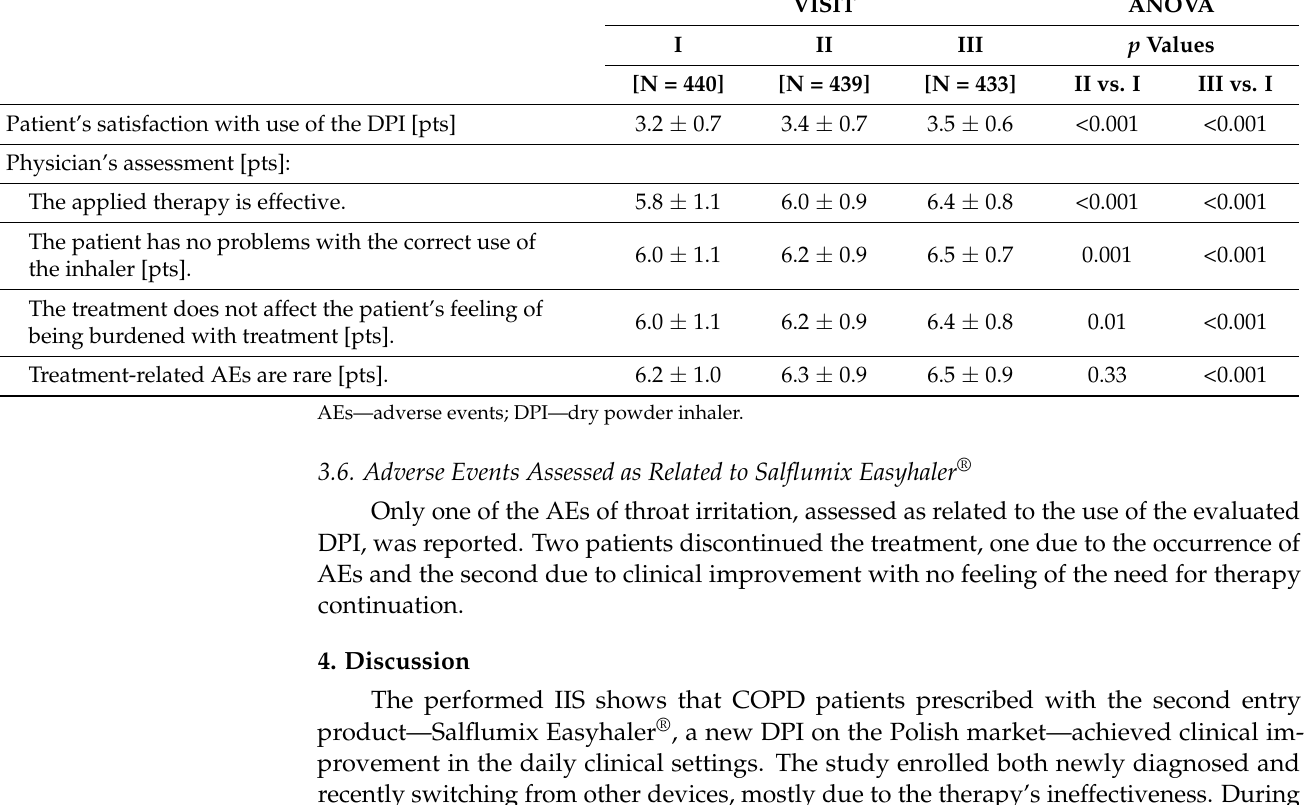
Table 3. Patients’ and physicians’ assessment of the use of Salflumix Easyhaler @ . VISIT ANOVA I II III p Values [N =